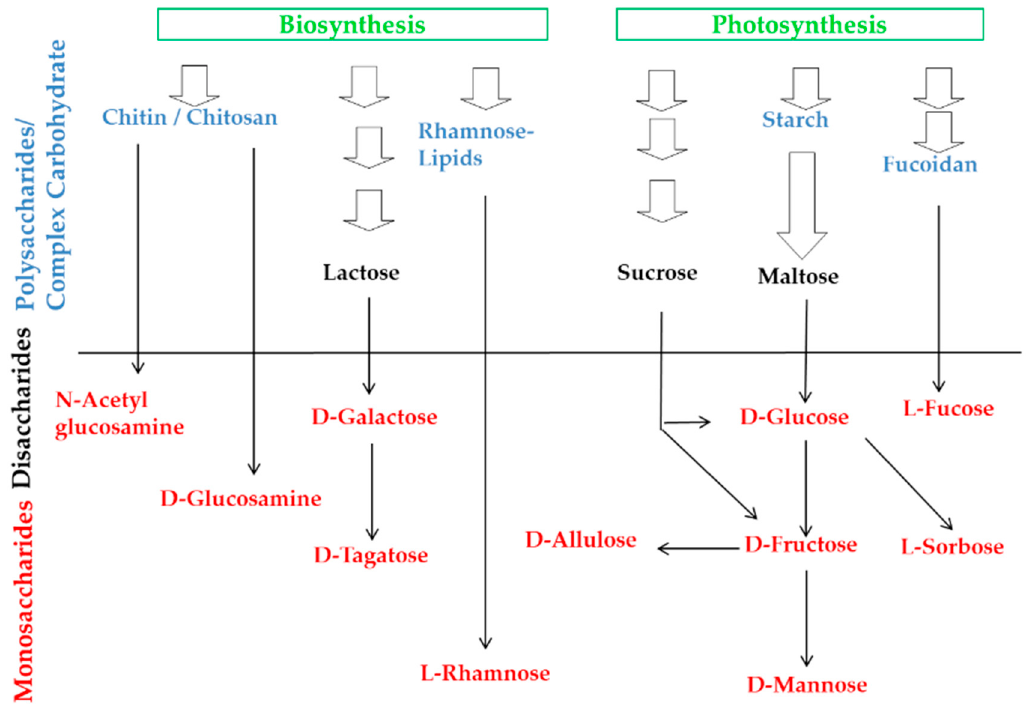
Figure 1. Hexoses derived from natural resources in the food industry.